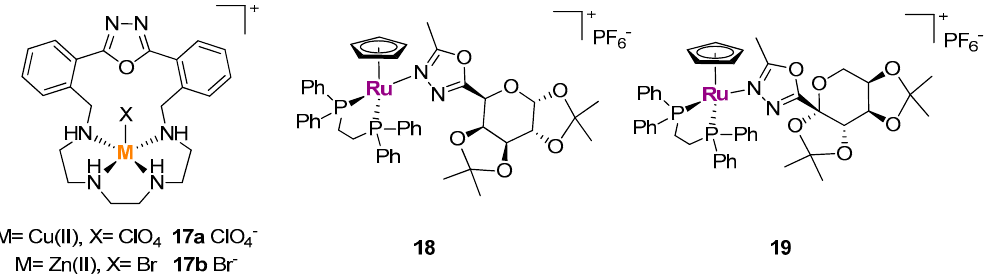
Figure 9. Structures of metal complexes with 1,3,4-oxadiazole ligands with biological activity.